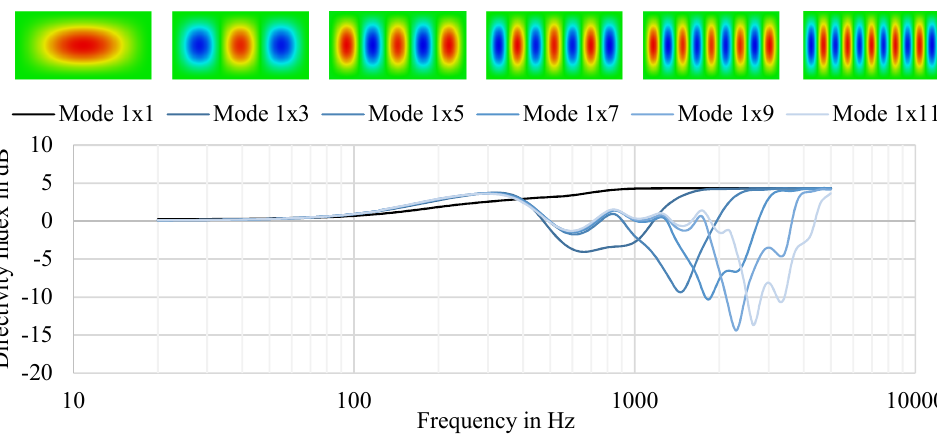
Figure 5. Overview of the mode shapes and DIs of modes with increasing wavenumber k x in the x direction. The results are calculated by solving only one individual mode in the simulation